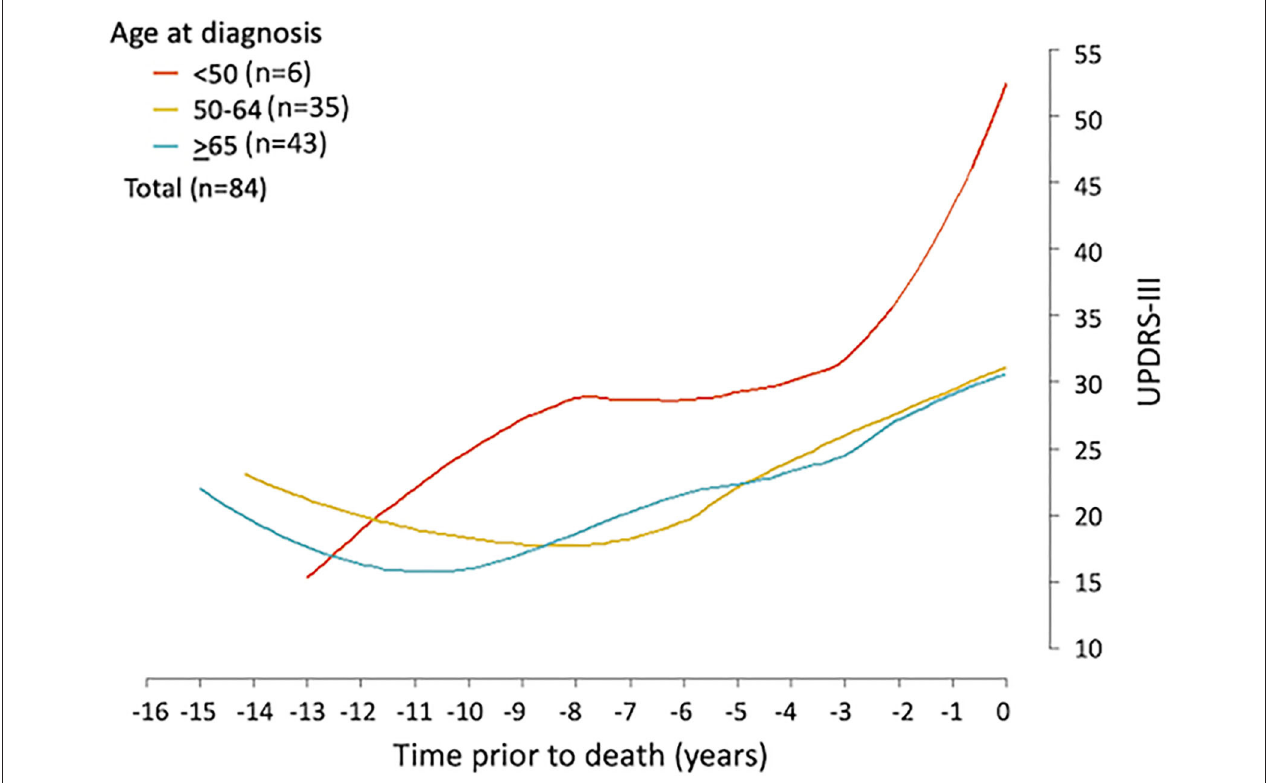
FIGURE 3 | UPDRS-III trajectory prior to death among Parkinson’s patients. Loess curves were estimated using UPDRS-III scores from PD patients ( n = 84) stratified by age at diagnosis, < 50, 50–64, and ≥ 65 years. The figure shows the loess curves of the UPDRS-III scores vs. time for the three age groups combining men and